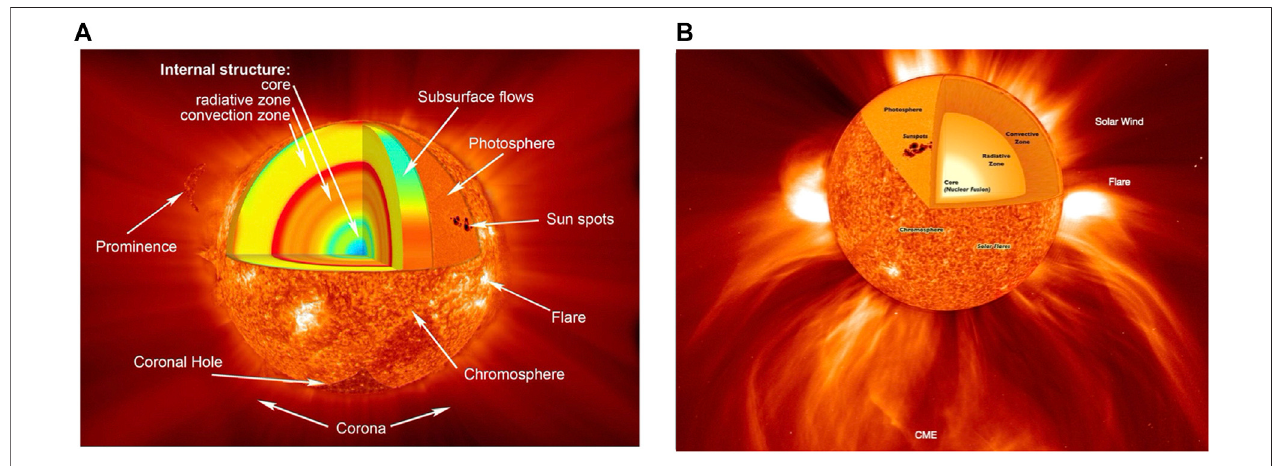
FIGURE 1 | (A) The main regions of the Sun including the interior, surface (photosphere) and atmosphere (chromosphere and corona). Image Credits: NASA/ Goddard. (B) Diagram adapted from SOHO/NASA representing the overall structure of the Sun including features such as CMEs, Flares, and the solar